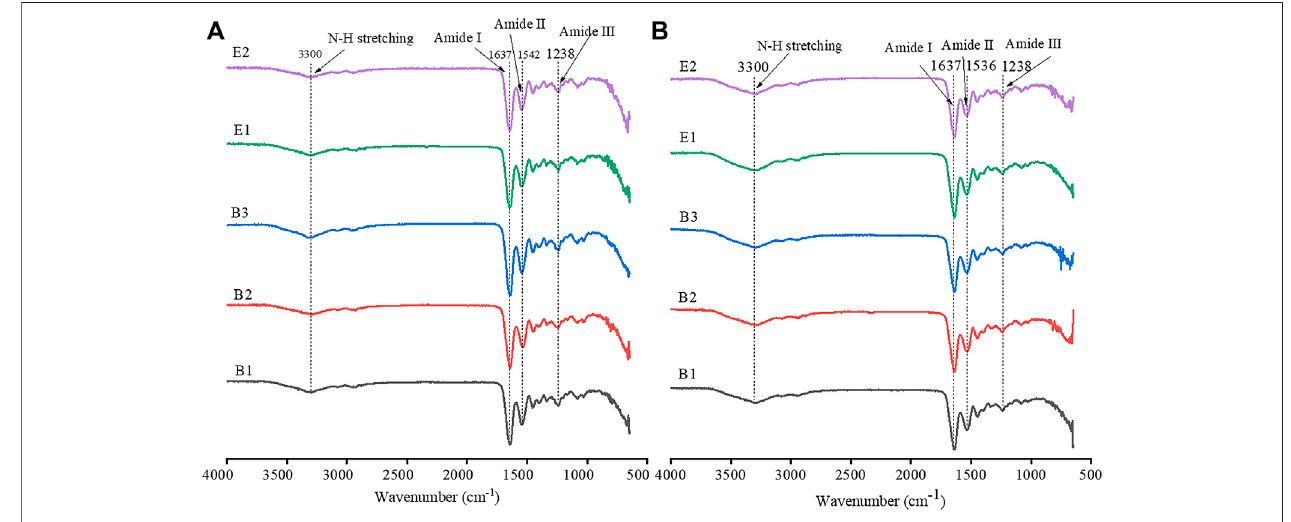
FIGURE 2 | Fourier Transform Infrared (FTIR) spectra of gelatin (A) and gelatin fi lm (B) .